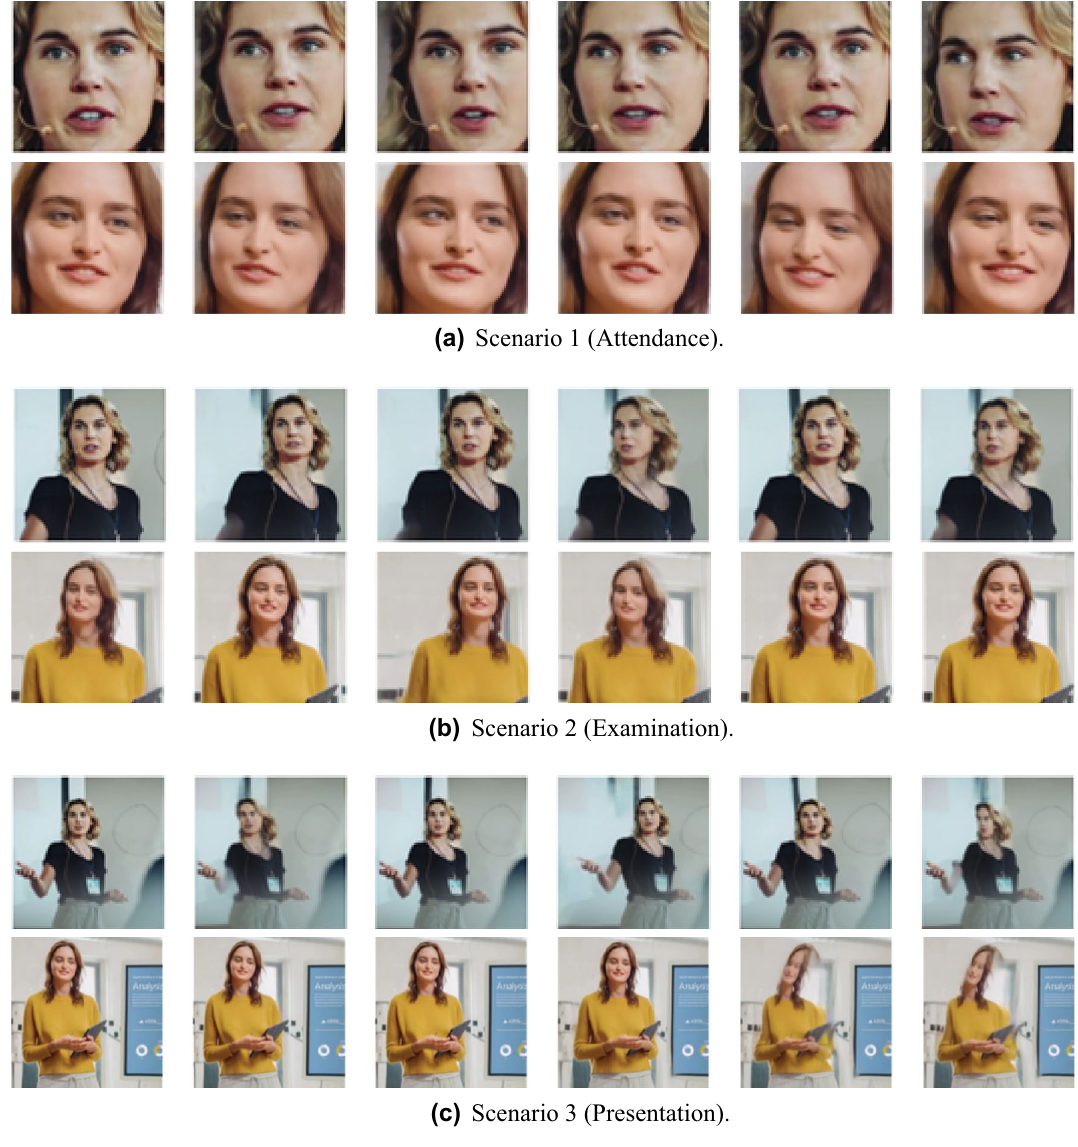
Figure 6. Sample frames of generated videos using the first order